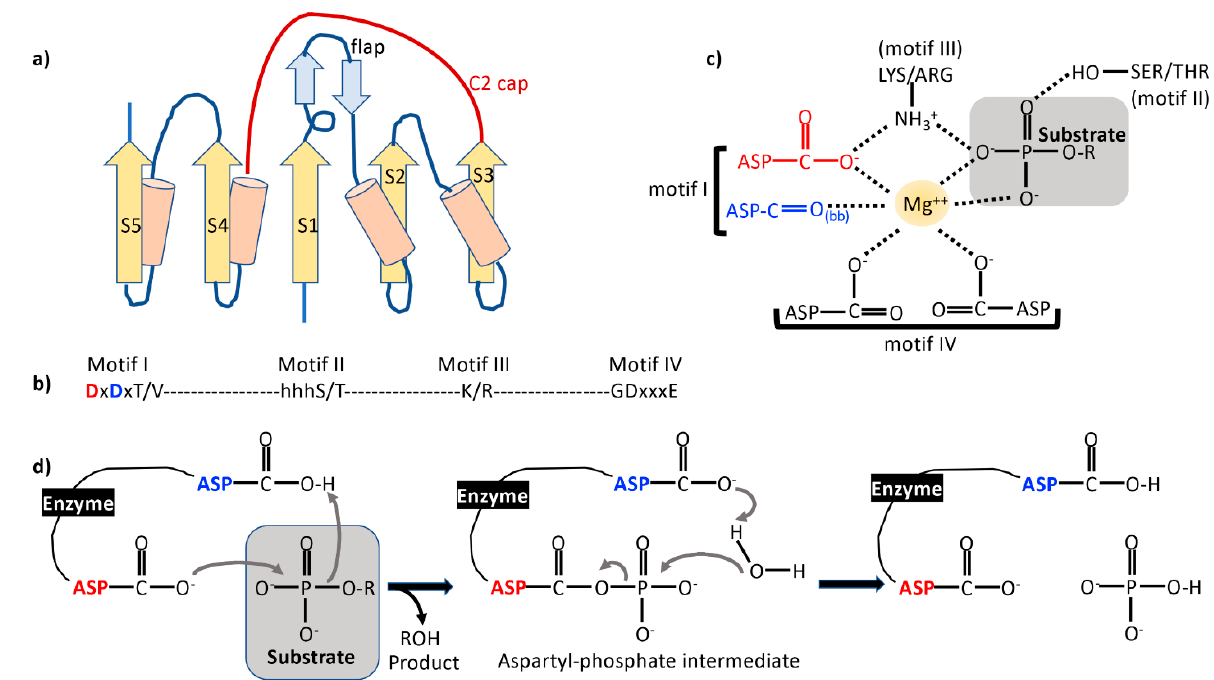
Figure 1. ( a ) Topology of a typical haloacid dehalogenase (HAD) phosphatase domain. β -strands are shown as yellow arrows and helices as cylinders. Strands are numbered S1–S5. Sample flap and C2 cap domains are illustrated. ( b ) The four sequence motifs that characterize HAD phosphatases. ( c ) Involvement of the amino acids in the conserved motifs in co-ordination of the obligate Mg 2+ ion and substrate interaction. bb refers to a backbone carbonyl group. ( d ) Schematic of the HAD phosphatase reaction mechanism. The nucleophilic Asp (red) and the general acid-base Asp (blue) from motif I are color coded.